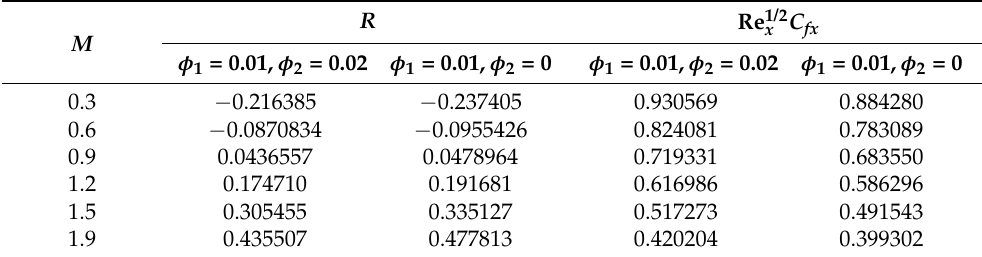
Table 9. As the thermocapillarity parameter M undergoes variation, numerical approximations are made for the local Nusselt number θ (cid:48) ( 0 ) based on specific parameters, including We x = 0.05, ε = 0.8,Pr = 7, S = − 1, and m = 0.6. M